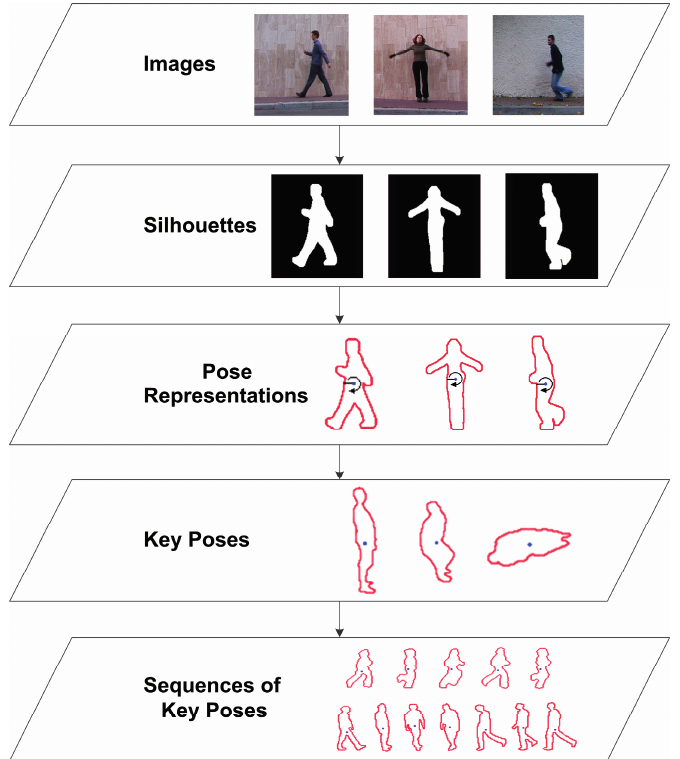
Figure 7. Overview of the proposed human action recognition